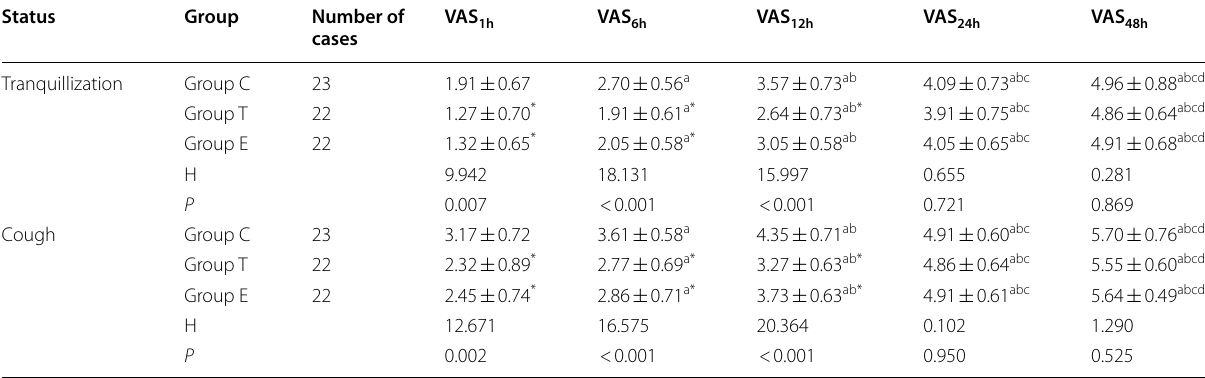
Group C was the control group, group T was the paravertebral nerve block group, group E was the erector spinal muscle plane block group, VAS: visual analogue score; a is compared with 1 h p < 0.05, b is compared with 6 h p < 0.05, c is compared with 12 h p < 0.05, d is compared with 24 h p < 0.05, * is compared with C group p <